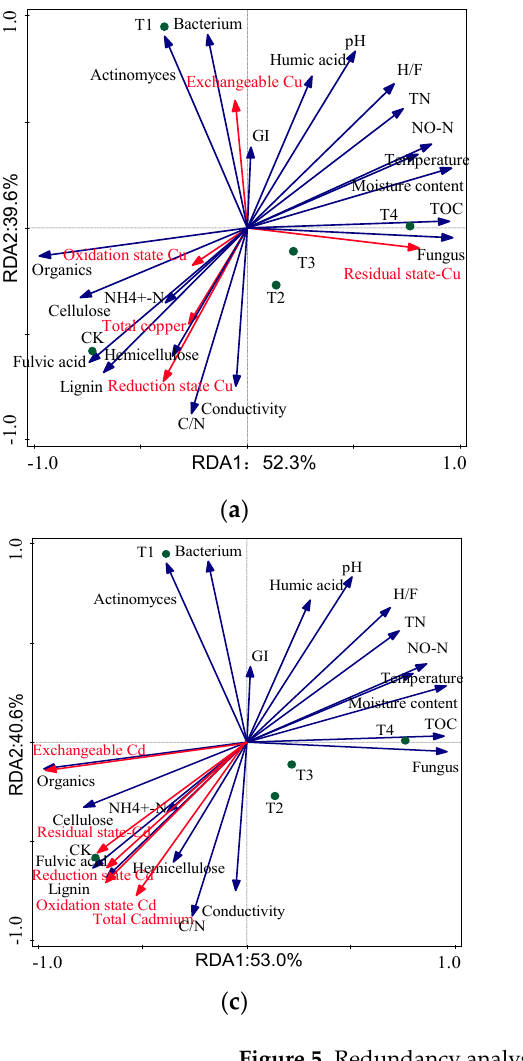
Figure 5. Redundancy analysis (RDA) of heavy metal speciation and physicochemical properties in compost with biochar addition: ( a ) Cu, ( b ) Zn, ( c ) Cd, and ( d ) Pb. Table 8. Redundancy analysis (RDA) results of heavy metals and physicochemical property factors in compost.